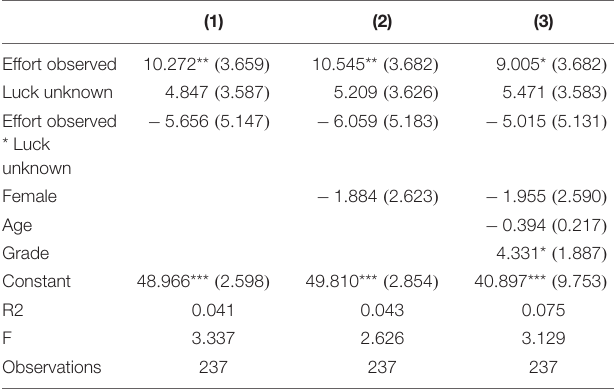
TABLE 6 | OLS regressions over effort provisions.